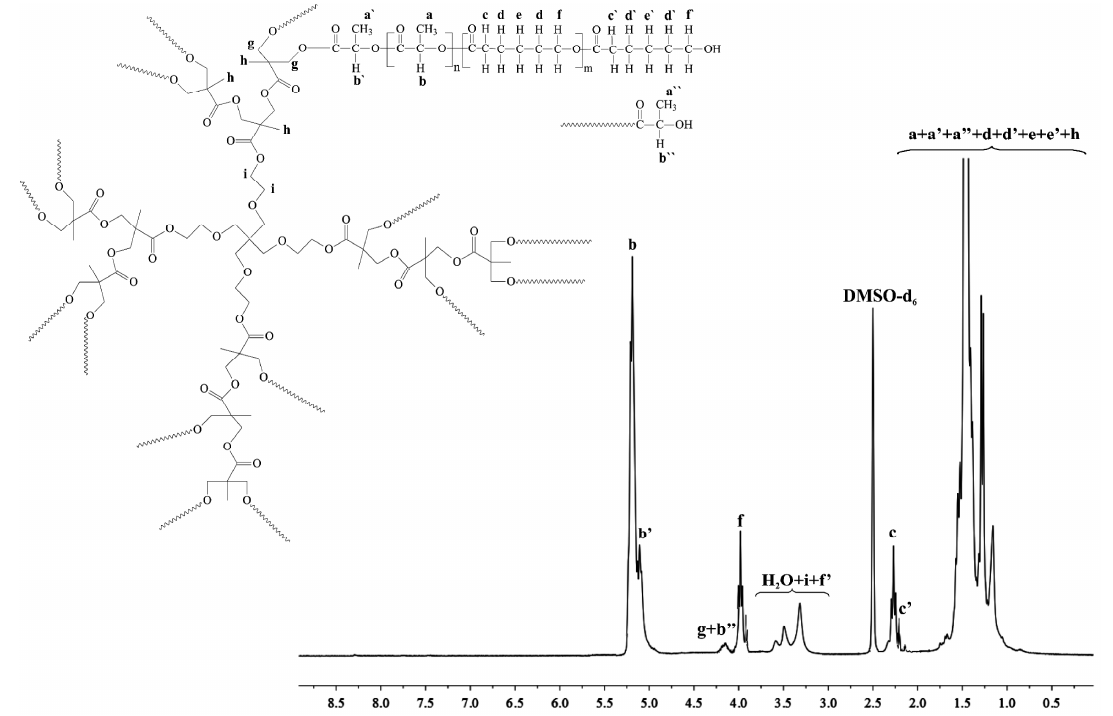
Figure 1. 1 H-NMR spectrum of bis-MPA-PLLA90-PKL38 sample.